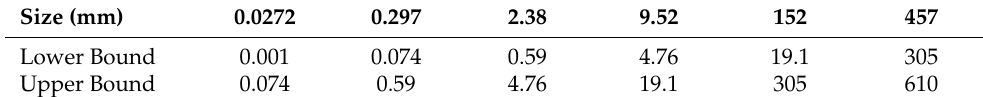
Table 4. Size classes in the JiJi Reservoir.